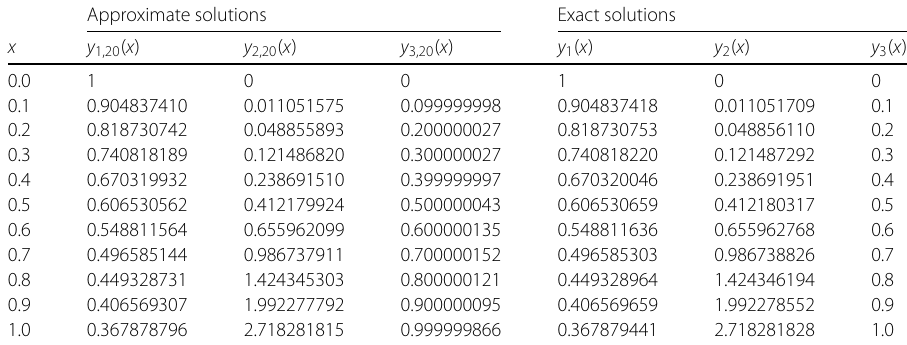
Table 4 Approximate solutions using the presented method with n = 20 for Example 2 Approximate solutions Exact solutions